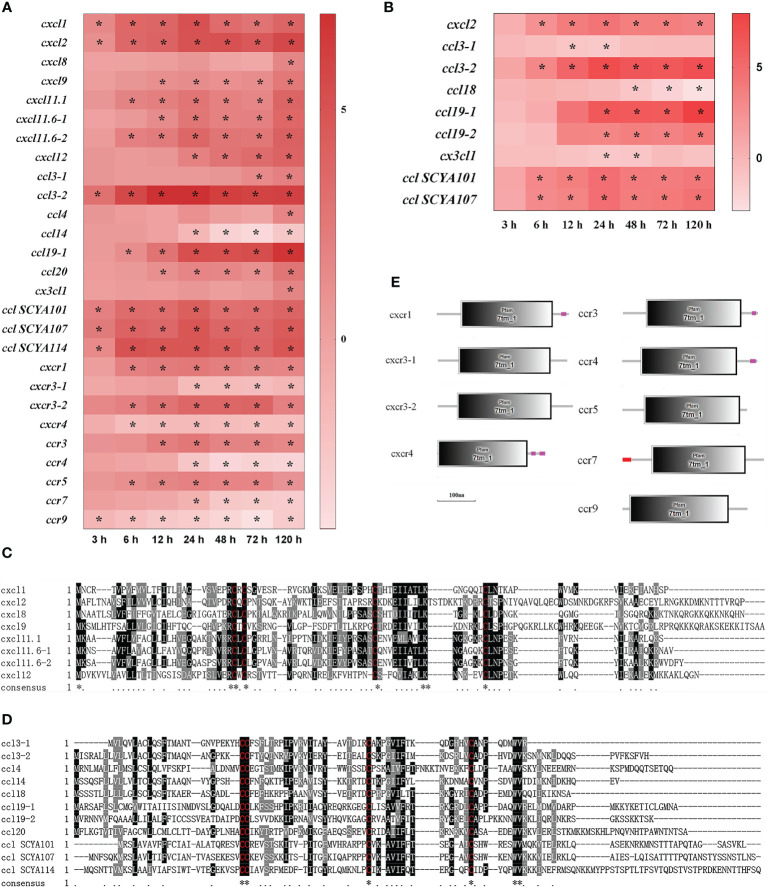
The DEGs of chemokine in yellow catfish after E. ictaluri infection. (A, B): The DEGs identified in the spleen and liver, respectively. The DEGs of chemokine were analyzed at 3 h, 6 h, 12 h, 24 h, 48 h, 72 h, and 120 h post-infection in the spleen and liver. The color gradient represents highly up-regulated (red) to highly down-regulated (white) genes. Significant differences at different time points post-infection compared to the control (0 h) are indicated by asterisks (*P < 0.05). (C, D): Multiple alignments of the deduced amino acid sequences of detected CXCLs and CCLs, respectively. The amino acid sequences of these genes were predicted using MEGA 6.06. ClustalW program in MEGA 6.06 and BoxShade were used for multiple sequence alignments. Similar amino acid residues are marked as grey shadow and identical residues as black shadow. Absent amino acids are indicated by dashes (-). (E): Structural features of chemokine receptor DEGs in yellow catfish. The domain organizations were predicted by the SMART online server.